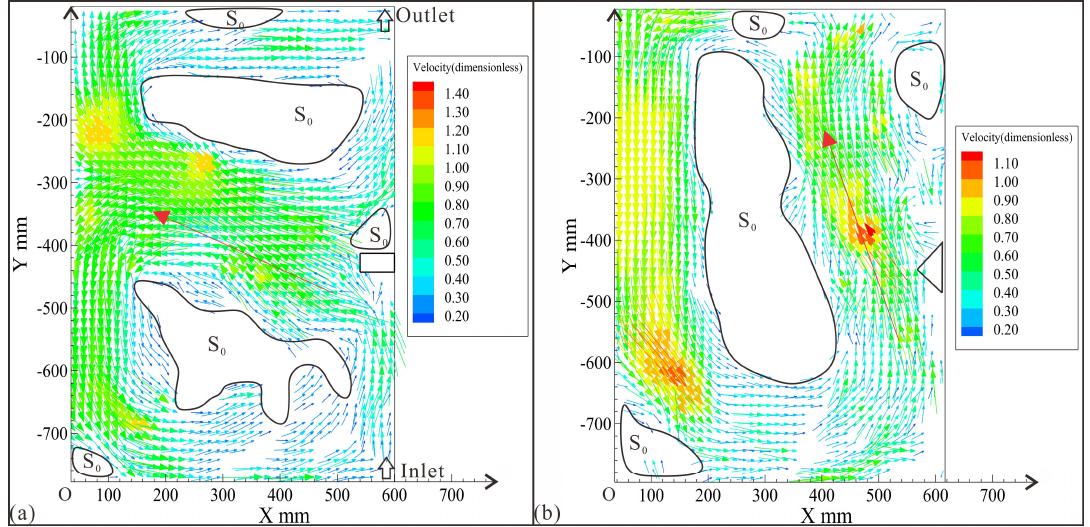
Figure 2. Distribution of the stagnant water area: ( a ) rectangular column, Q = 6.8 L/min, l = 0.44; ( b ) triangular prism, Q = 6.8 L/min, l = 0.44.